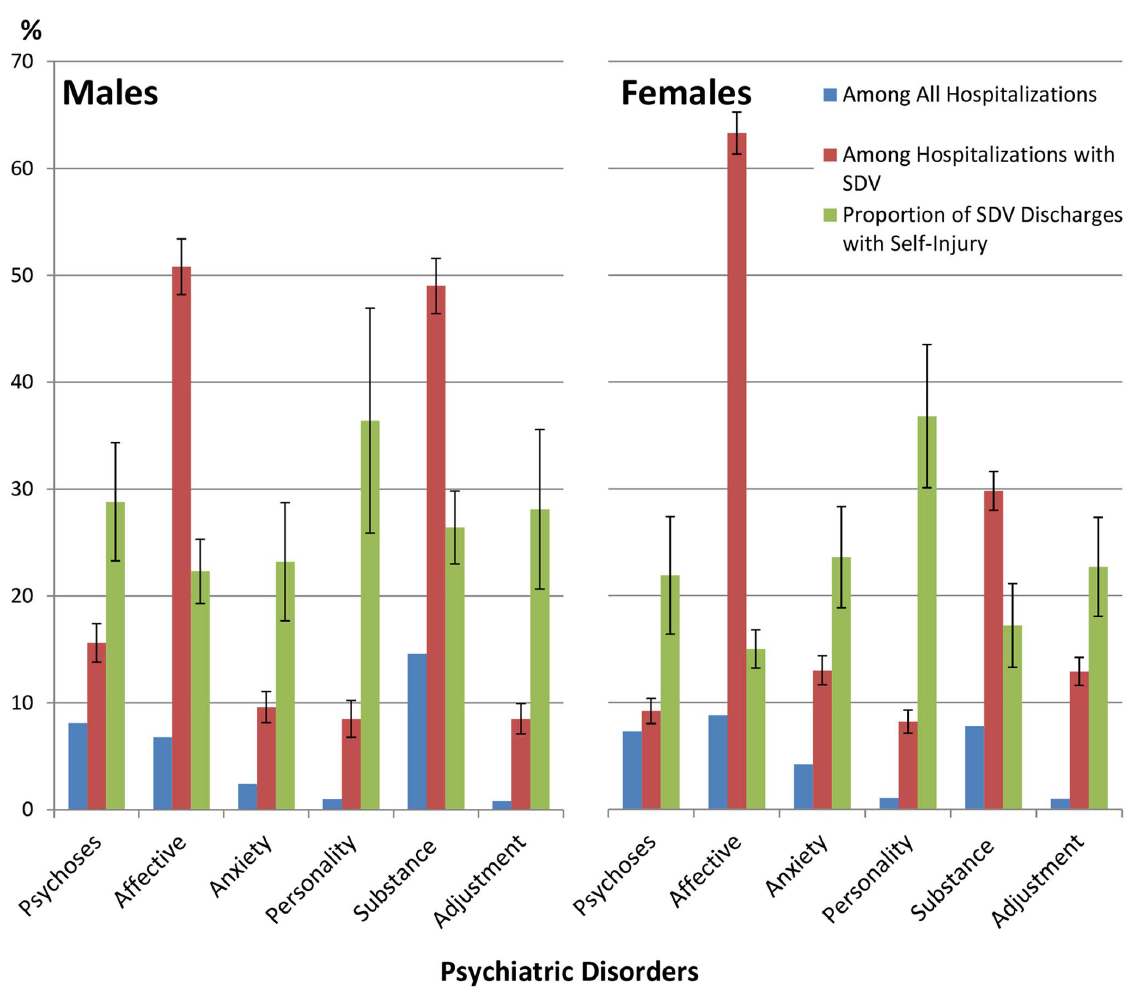
Figure 2. Relationship between psychiatric disorders and non-fatal self-directed violence in hospital discharges. The first two columns of each set represent the proportion of discharges with psychiatric disorders that occur among all hospitalizations or among all SDV discharges, respectively. The third column relates to the method of SDV if a discharge record has the given comorbid psychiatric disorder. The column presents the percentage of SDV discharges with self-injury as opposed to self-poisoning. Error bars are shown if the 95% CI for the weighted sample exceeds 2%.